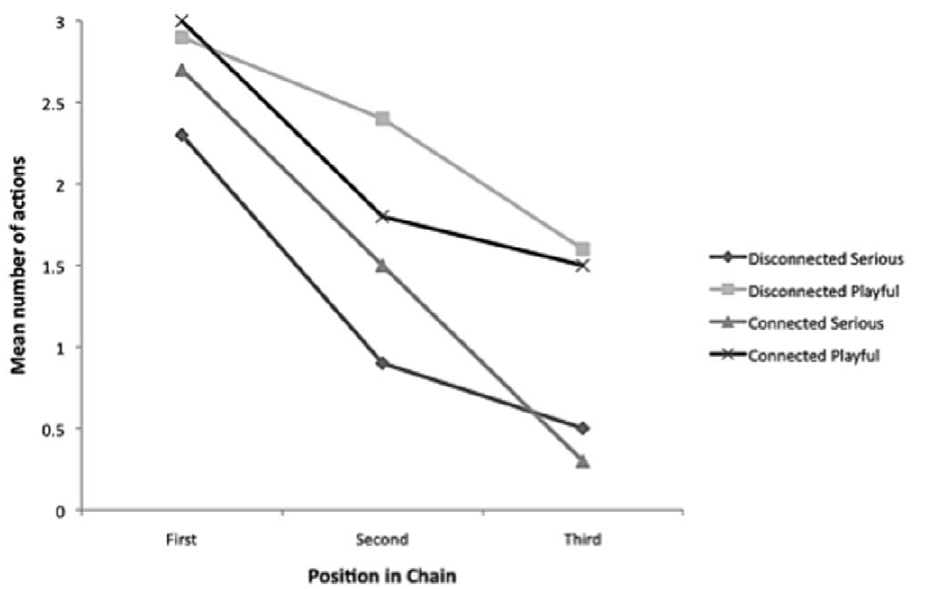
Figure 1. Mean number (and standard error) of total actions reproduced across conditions (Playful, Functional, No Model) at each step in the chains (First, Second, Third).